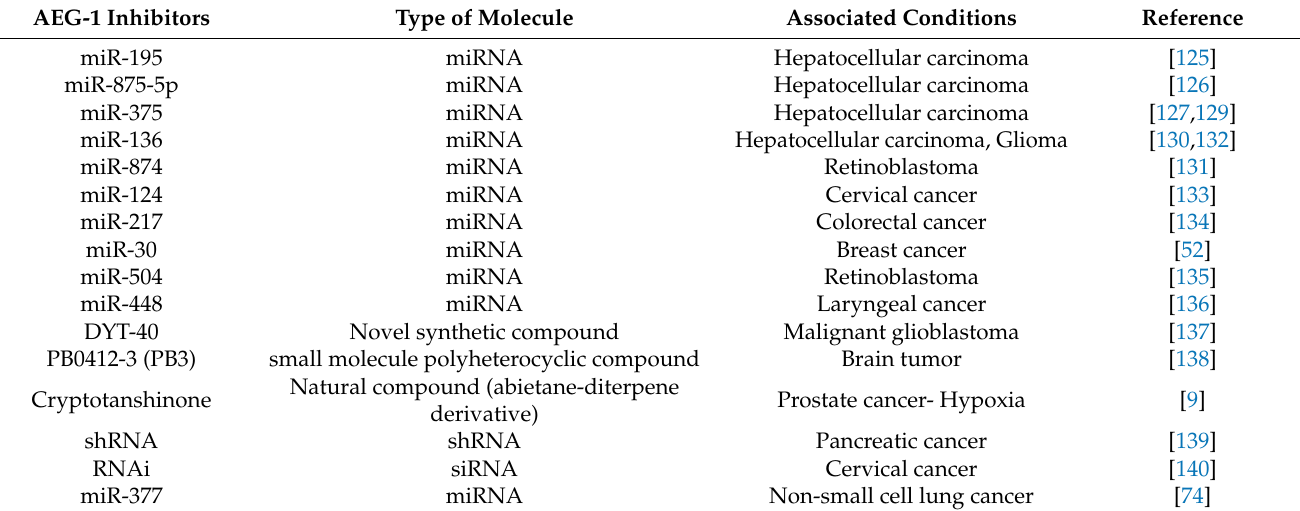
Table 1. List of miRNAs and siRNA as AEG-1 inhibitors in different cancer